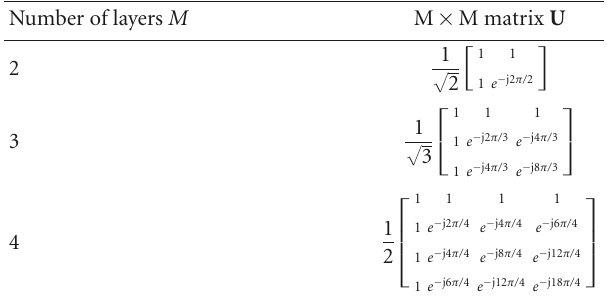
Table 6: Precoding matrix C k ( k = 1,2,3,4) for the open-loop spatial multiplexing.